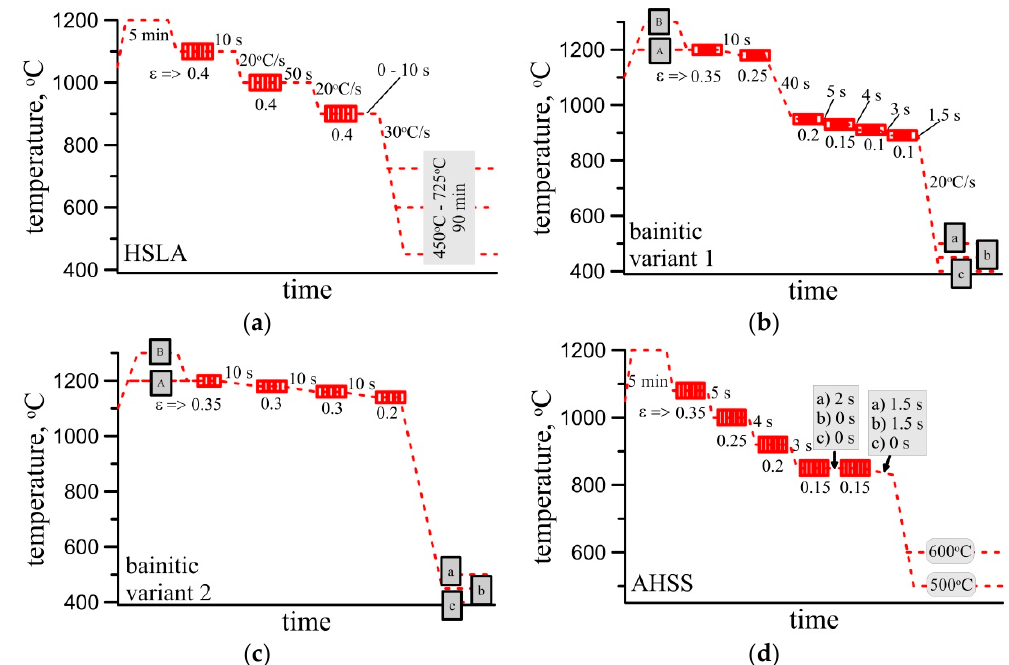
Figure 2. Simulated rolling schedules for HSLA steels ( a ), bainitic steels ( b , c ), and AHSS grades ( d ).